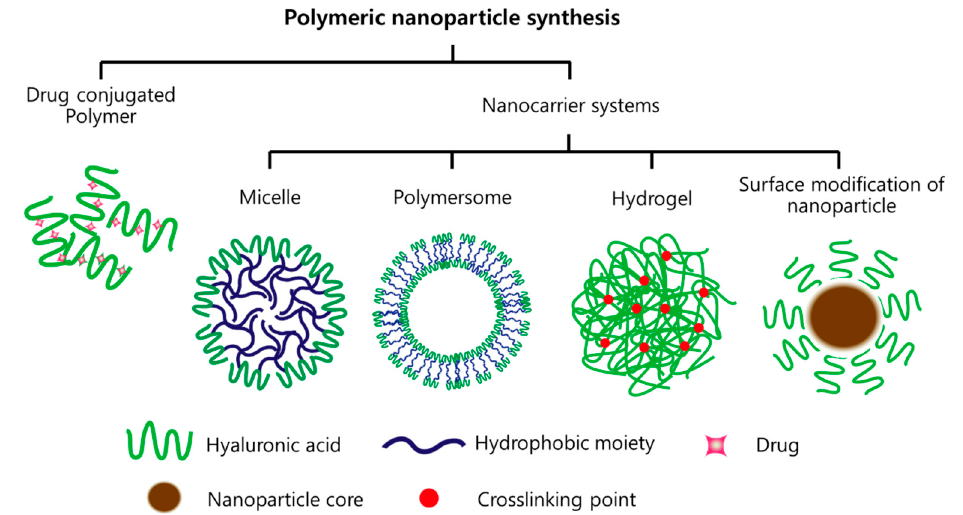
Figure 1. Formulations of hyaluronic acid (HA)-based nanomaterials.